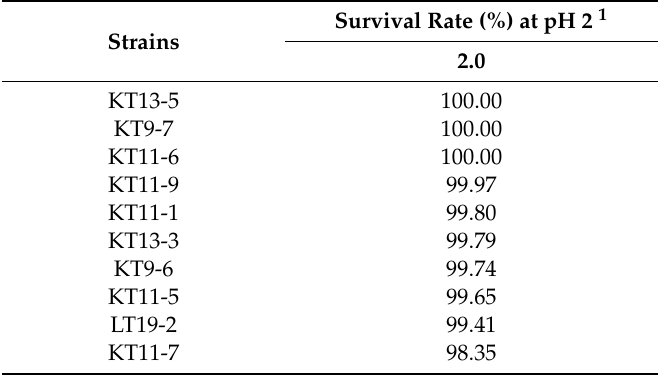
Table 1. Acid tolerance of 10 selected strains.